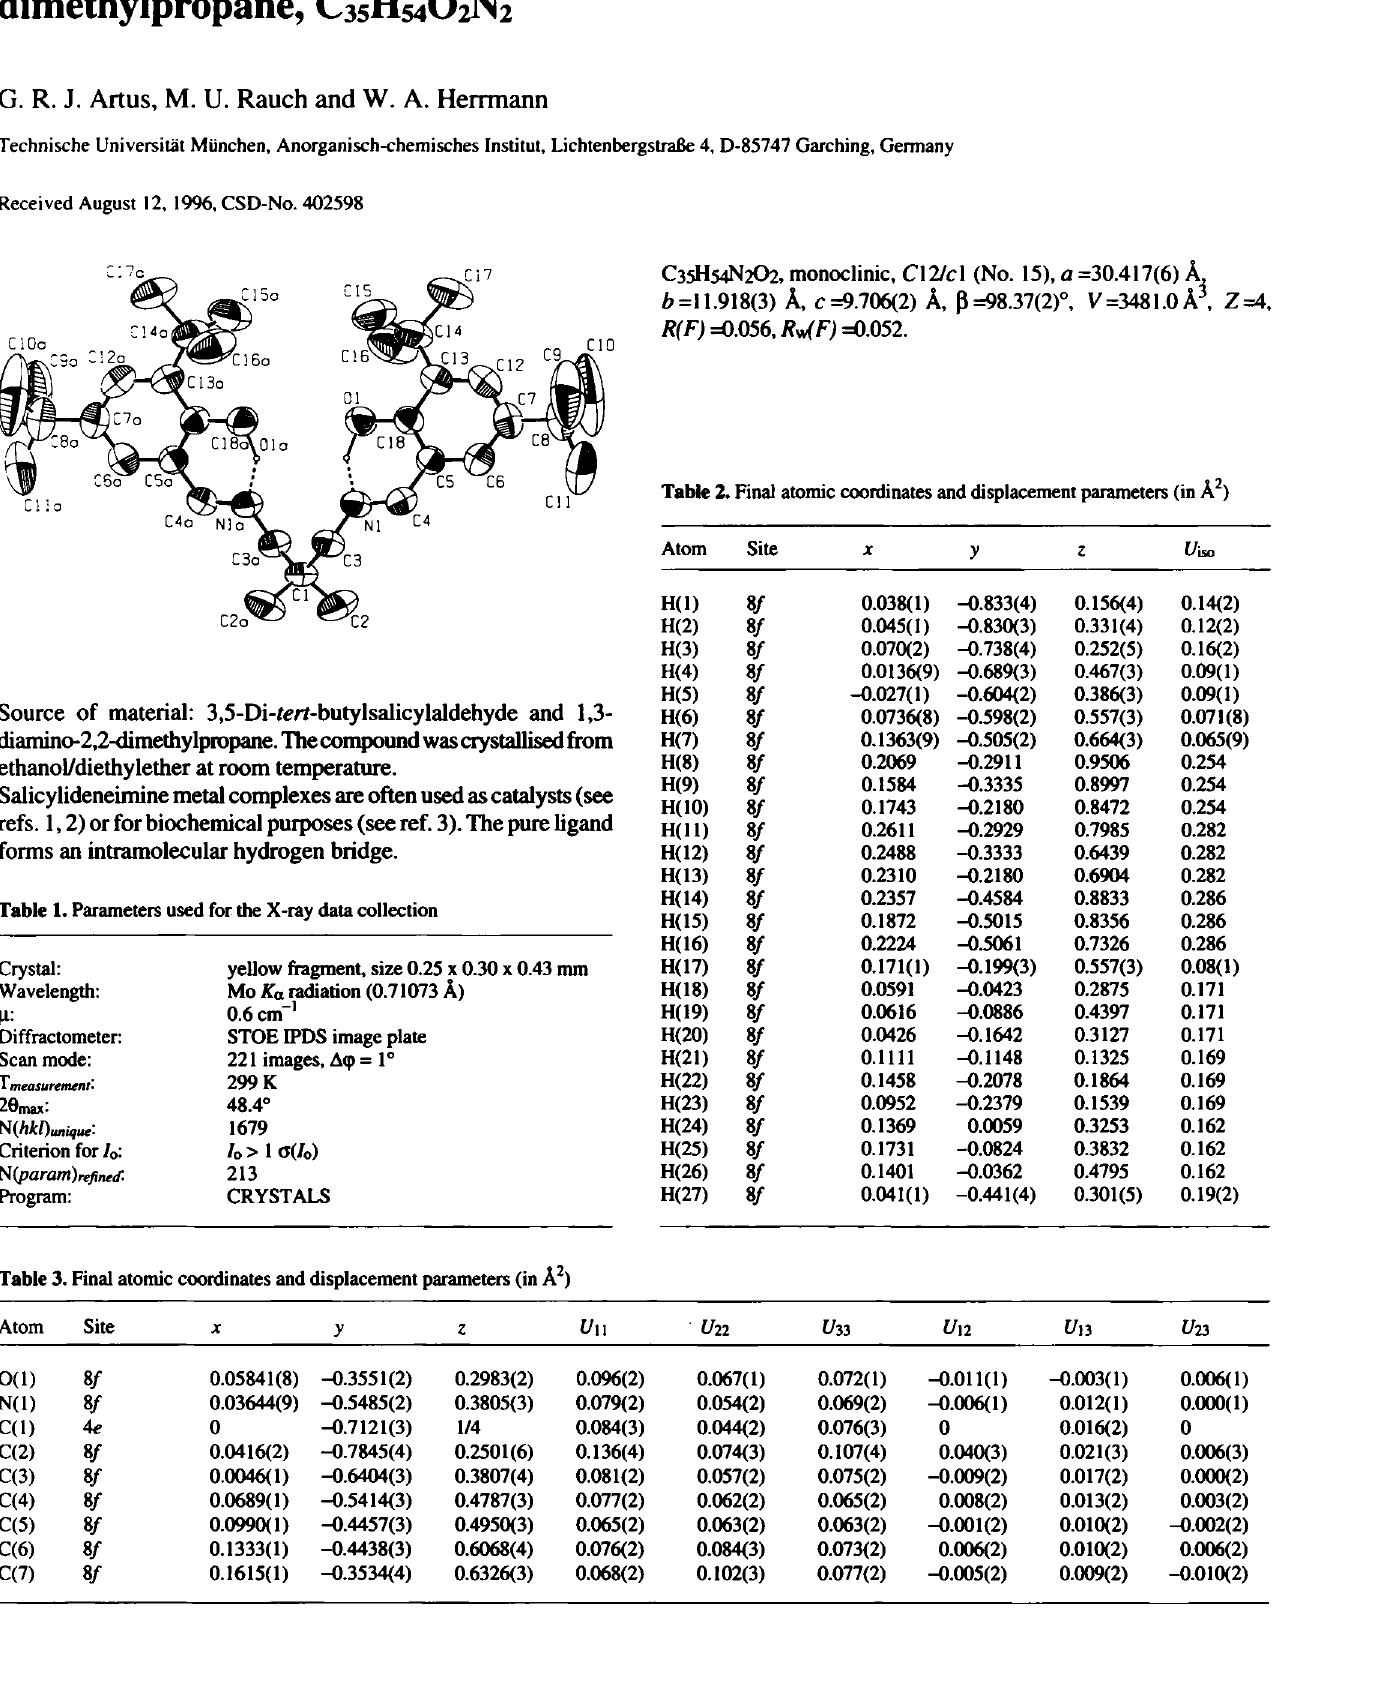
Table 2. Final atomic coordinates and displacement parameters (in Â 2 )